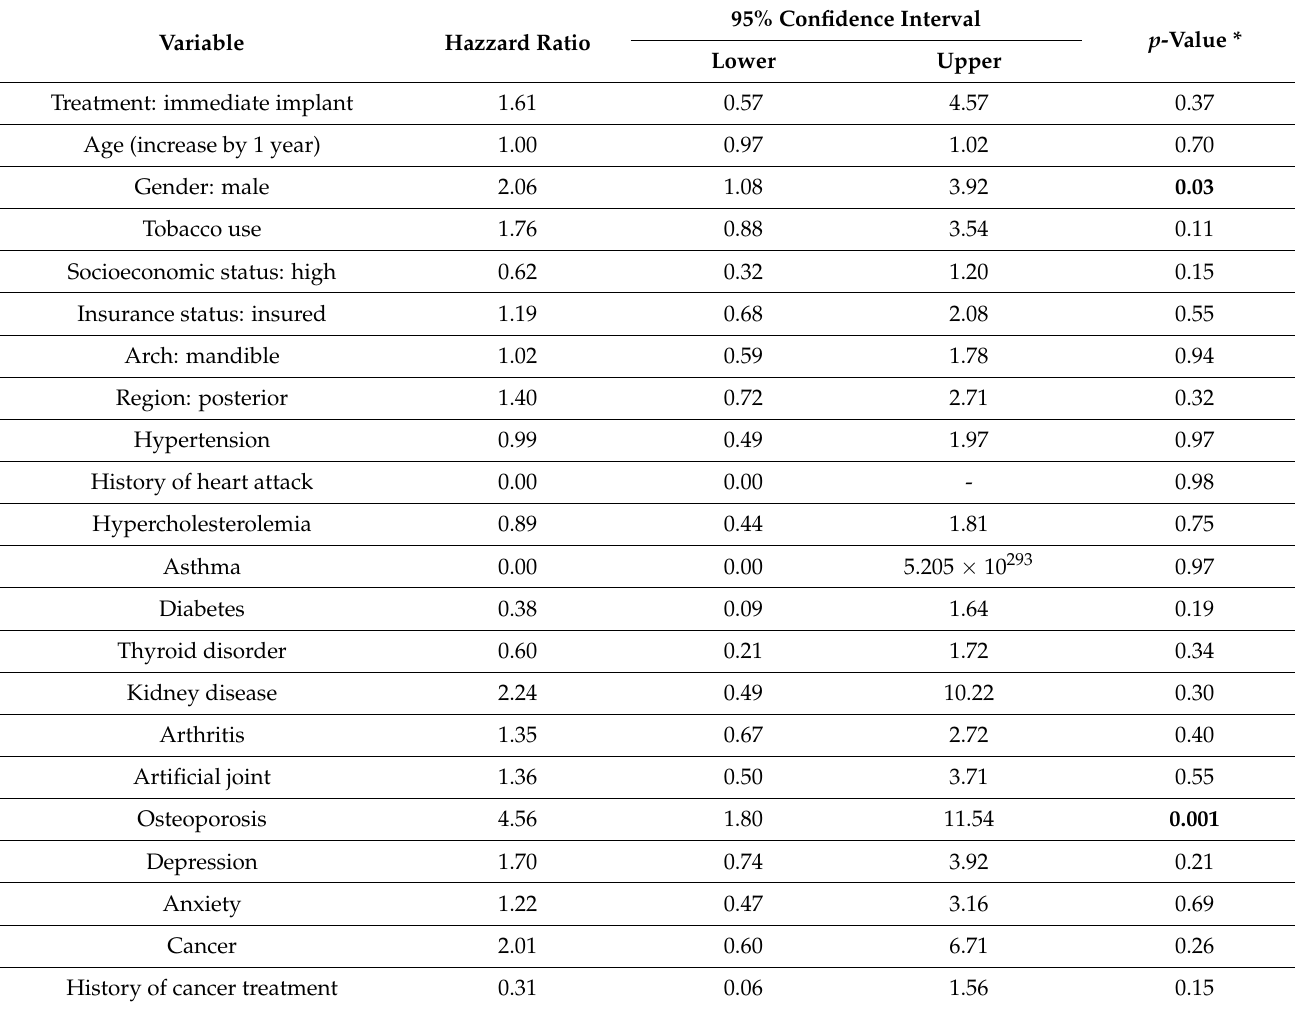
Table 2. Multivariable Cox regression model. Summary for immediate and delayed implant place- ment for the characteristics